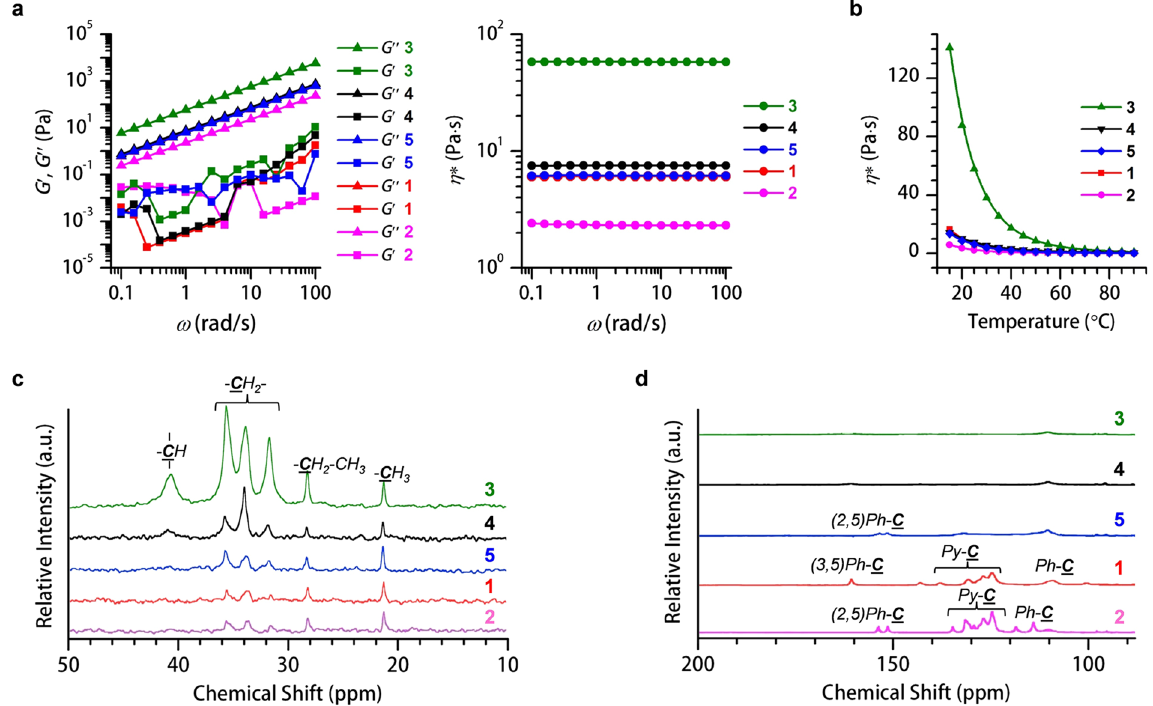
Figure 3. Liquid-physical properties of 1 – 5 . ( a ) Variation of storage elastic modulus ( G ′ , square), viscous loss modulus ( G ″ , triangle) (left) and complex viscosity ( ƞ * , circle) (right) as a function of angular frequency ( ω ) for neat samples of 1 (red), 2 (pink), 3 (green), 4 (black) and 5 (blue) with a strain amplitude ( γ ) = 0.25 at 25 °C. The viscosities are ordered as: 3 > 4 > 5 ≥ 1 > 2 . ( b ) ƞ * as a function of temperature. γ = 0.25, ω = 10 rad s − 1 . Solid-state 13 C NMR spectra, ( c ) CP-MAS and ( d ) DD-MAS mode of 1 (red), 2 (pink), 3 (green), 4 (black) and 5 (blue) measured at 27 °C. The intensity of CP-MAS follows an order of 3 > 4 > 5 ≥ 1 > 2 while the intensity of DD-MAS is on an order of 3 < 4 < 5 < 1 < 2